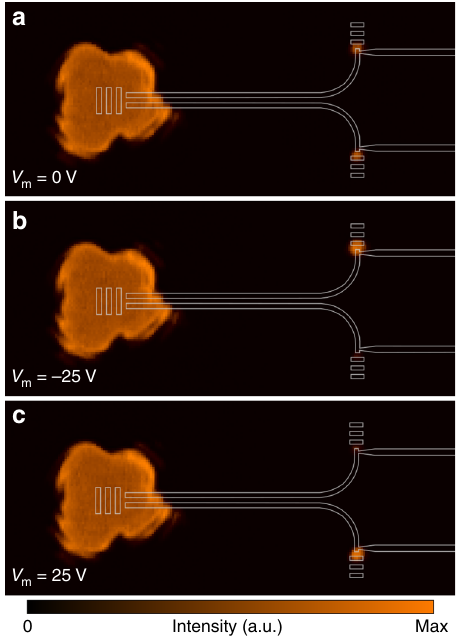
Fig. 3 Visualization of switching and modulation behavior. Experimental optical far- fi eld images captured by an infrared camera at different modulation voltages. A diffraction-limited beam ( λ 0 = 1550 nm) is positioned on the input grating to symmetrically feed the coupling system. The structure design is superimposed as a guide to the eye. The scattering images are superimposed with the structure design. a The unbiased device ( V m = 0 V) exhibits equal power distribution of the scattered signal emitted from the output ports, due to the symmetry of the directional coupler. b When a negative bias voltage ( V m = − 25 V) is applied, an enhancement of the optical output signal of the biased waveguide arm is observed, while the optical signal at the opposite output port is decreased in intensity. c By changing the polarity of the applied voltage, the intensity in the two output terminals is